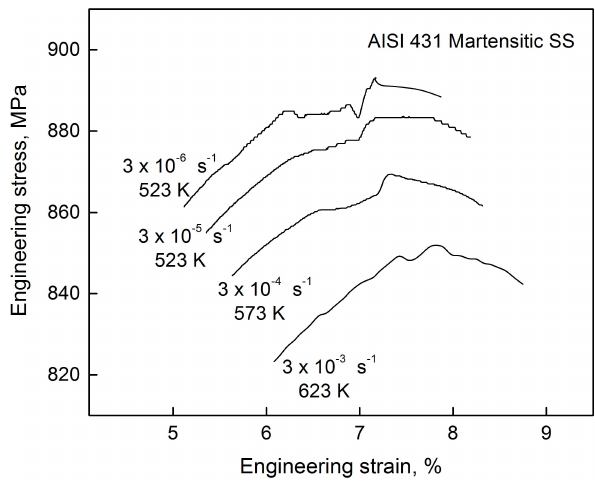
Figure 8: Typical serrations/jerky flow observed in the tensile en- gineering stress – engineering strain plot of AISI 431 martensitic stainless steel at 523-623